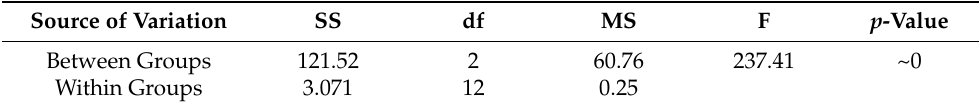
Table 3. ANOVA analysis for the tensile modulus.